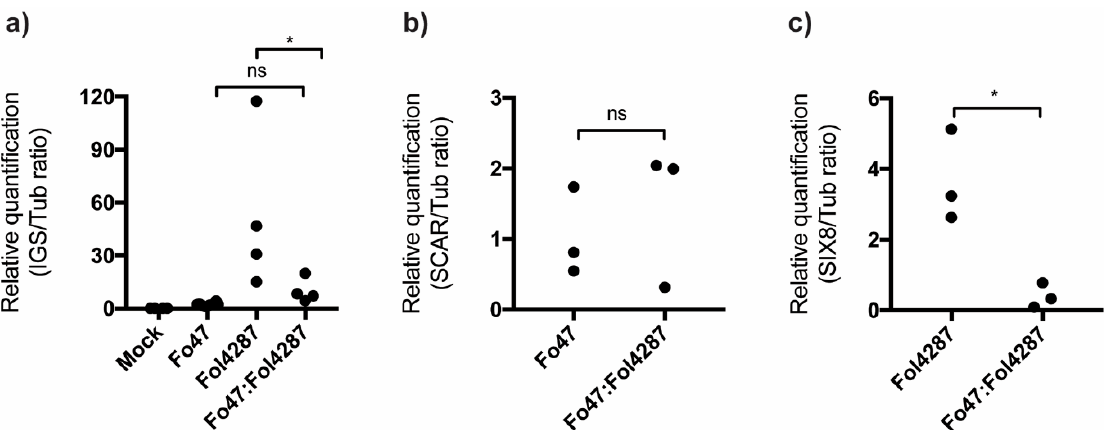
Figure 4. Coinoculated tomato roots are less extensively colonized by pathogenic strain Fol4287. Colonization was assessed by the qPCR using ( a ) Fo InterGenic Spacer (IGS) primers, ( b ) Fo47 marker SCAR, or ( c ) Fol marker SIX8 . Data obtained by quantifying IGS were analysed by an ANOVA with a Tukey multiple comparison test, and in the case of data for SCAR and SIX8 with a Student’s t-test. ( ns P > 0.05; * p < 0.05; ** p <